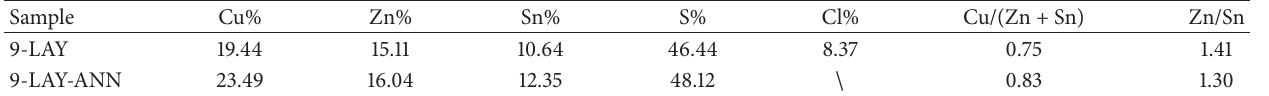
Table 5: The compositions of the CZTS thin